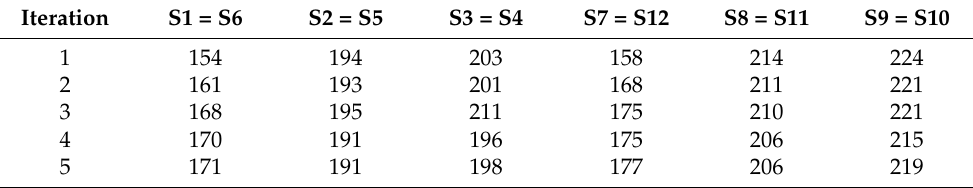
Table 4. Displacements evolution on footings in the BEM model